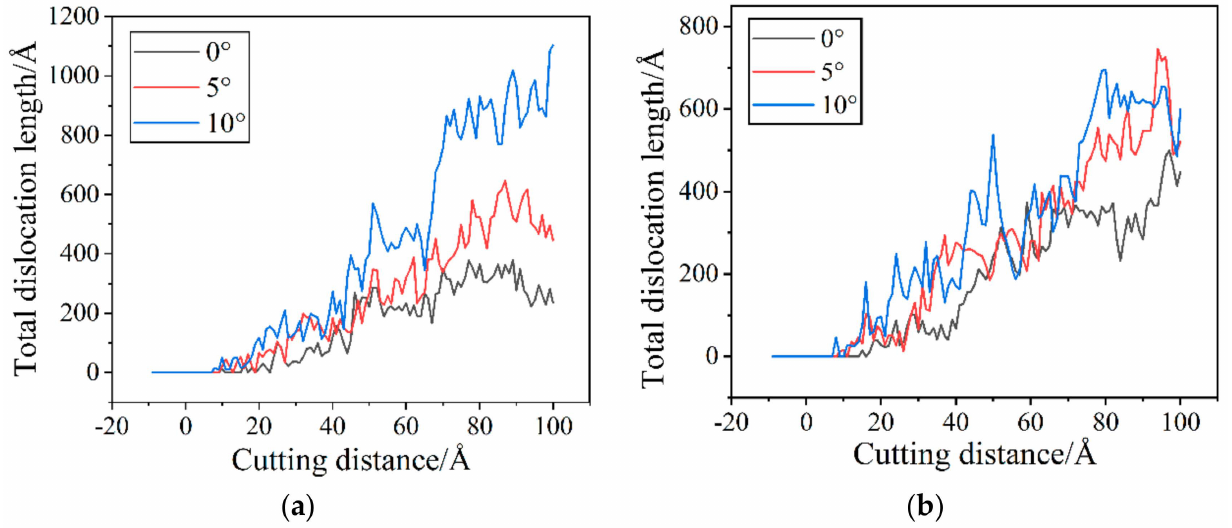
Figure 16. Total dislocation length changes under different cutting angles. ( a ) Dry cutting; and ( b ) wet